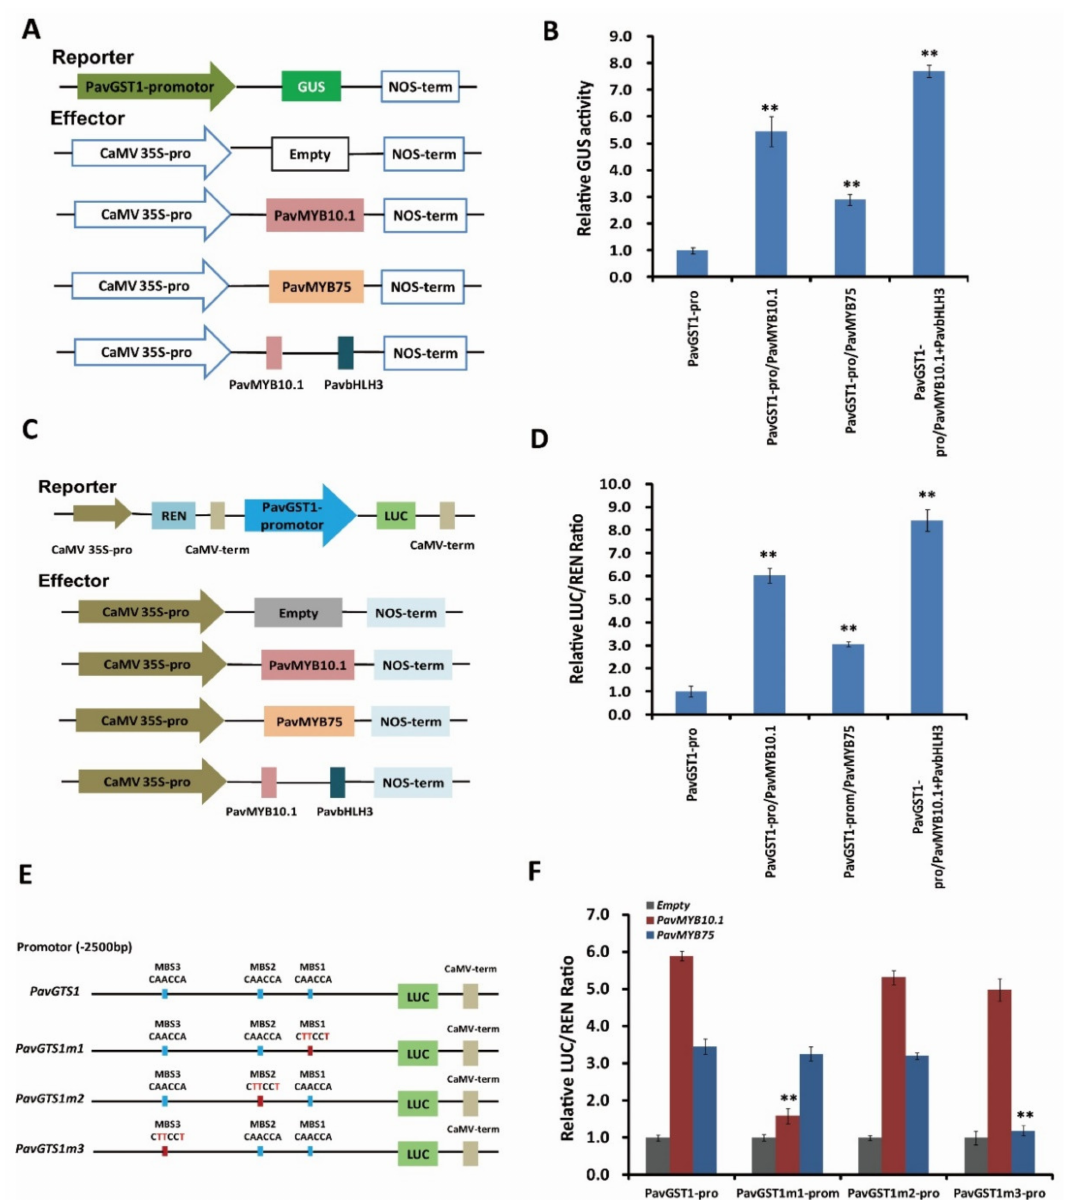
Figure 7. Direct activation of the PavGST1 promoter by PavMYB10.1 and PavMYB75. ( A ) Effector and reporter vector construction diagrams for GUS activity assays. ( B ) Results of GUS activity assays showing that PavMYB10.1, PavMYB75, and PavMYB10+PavbHLH3 all significantly activated the promoter of PavGST1. ( C ) Schematic representation of effector and reporter vectors used for dual-luciferase assays. ( D ) Effects of PavMYB10.1, PavMYB75, and PavMYB10+PavbHLH3 on PavGST1 promoter activity according to dual-luciferase assays. ( E ) Schematic diagram of PavGST1 promoter motif mutations. ( F ) Effects of PavMYB10.1 and PavMYB75 on the activities of original and mutated promoters of PavGST1 in dual-luciferase reporter assays. Each experiment included three replicates. Values represent means ± SD from six independent replicates. Significant differences were determined using Student’s t -test (**, p <